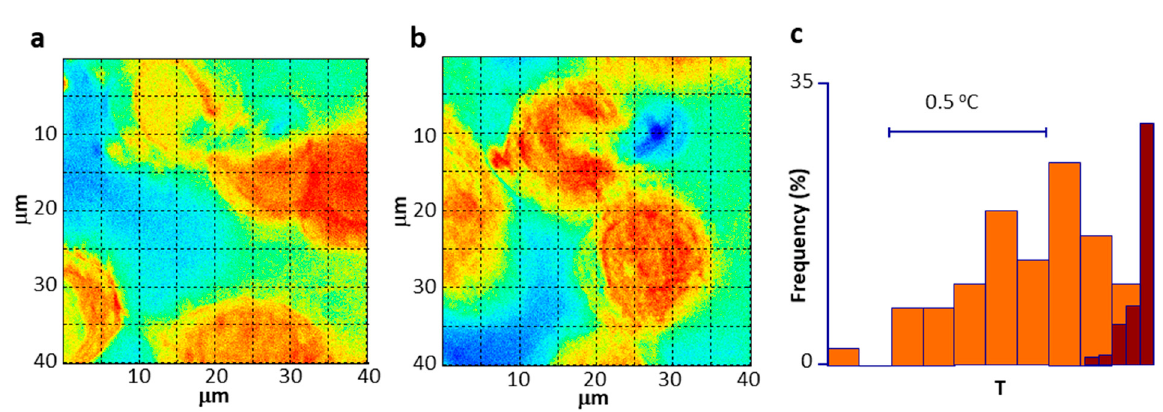
Figure 6. Thermal images of MNPs internalized in cells, ( a ), before, and ( b ), during irradiation with an AC magnetic field; ( c ), average temperature shift upon the application of an AC magnetic field.